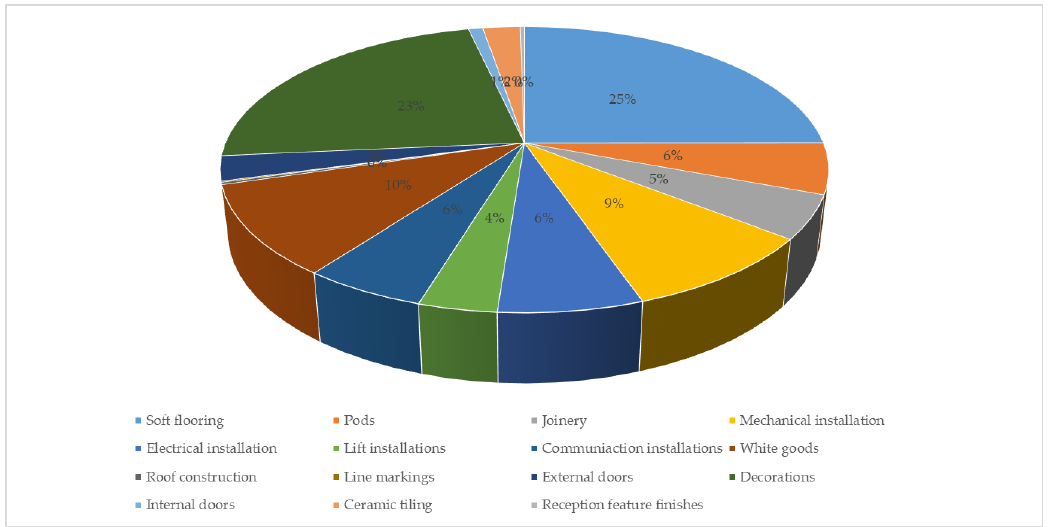
Figure 9. Elemental WLC breakdown of a complete BTR building over a 15-year period 3.2.5. Challenges to WLC estimation using BIM.